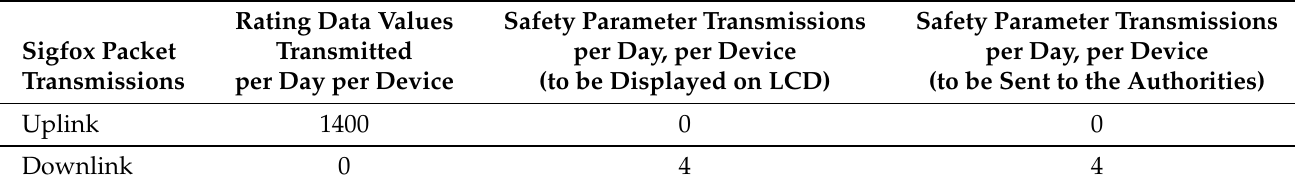
Table 3. Maximum packet transmissions and receptions through the Sigfox network for the case study.